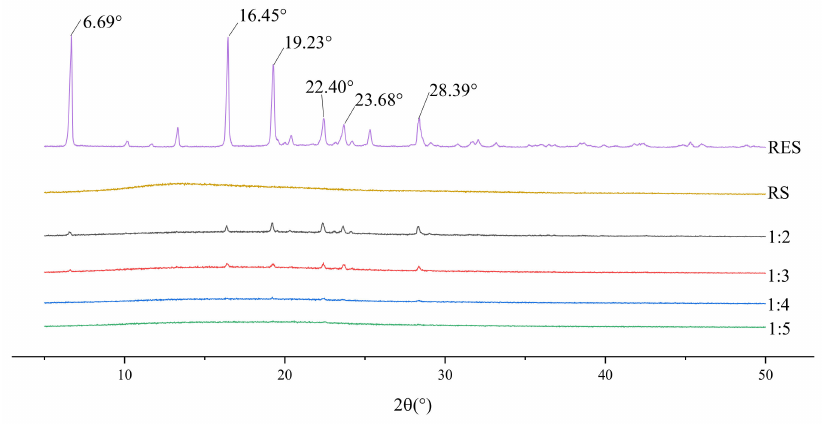
Figure 2. XRD diagram of solid dispersion prepared by different drug loading ratios.